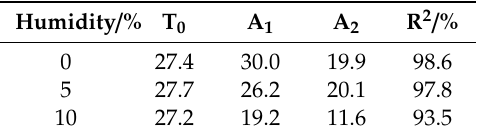
Table 4. Related coe ffi cients for limit load and temperature.